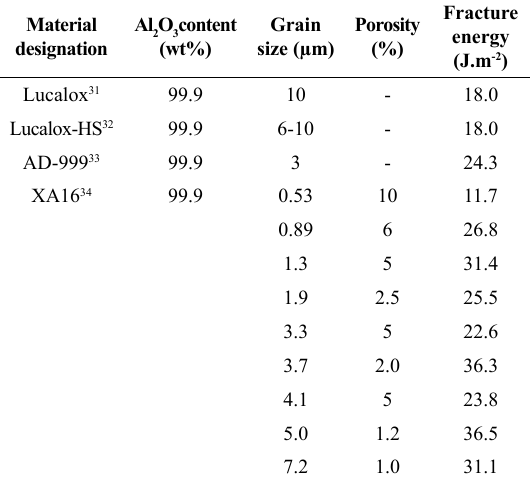
Figure 4. Fracture energy of composites. Table 2. Fracture energy data from